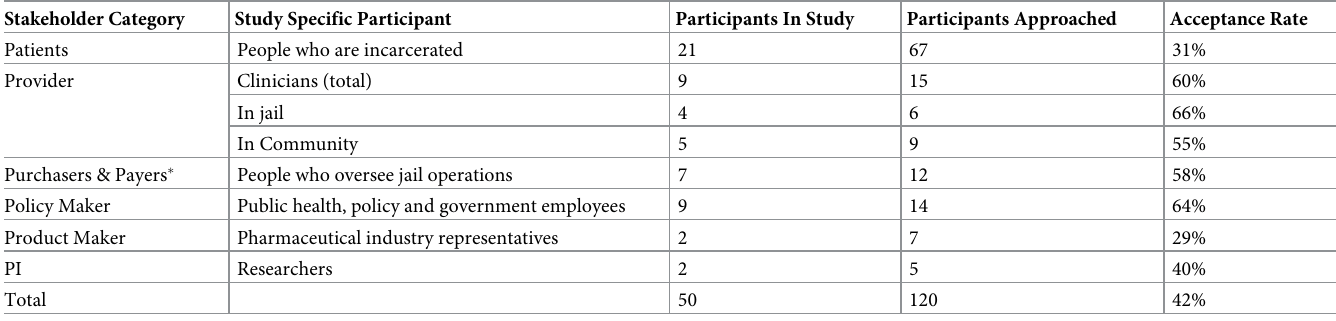
Table 1. 7 Ps: Study